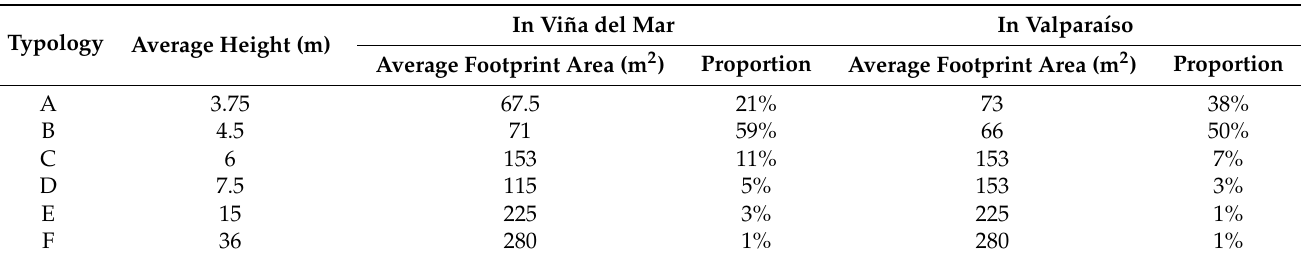
Table 2. Average footprint areas and heights derived for the six subcategories in the range A–F for Viña del Mar and Valpara í